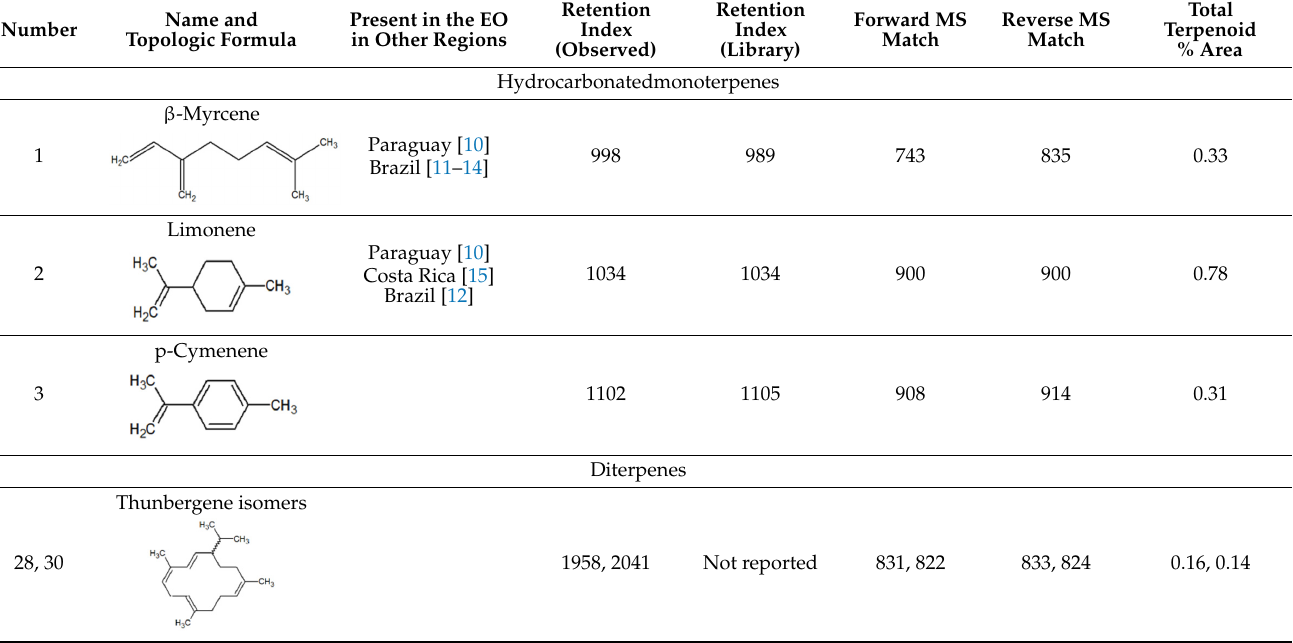
Figure 3. GC × GC-TOFMS extracted ion chromatogram (EIC) contour plot obtained from Z. caribaeum essential oil with the tentatively identified compounds labelled. The extracted masses are terpenoid ions m / z = 91, 93, and 121. The essential oil of the fresh leaves of ZC was recovered in a 0.06% yield, and the terpenoid compounds are displayed in Table 1. Thirty terpenoids were tentatively identified and numbered according to their retention orders in Figure 3 and Table 1. The relative amounts of each terpenoid are provided as a percentage of the total identified terpenoid peak areas. Table 1. Topological formulae of the molecules present in the Zanthoxylum caribaeum essential oil from Guadeloupe.